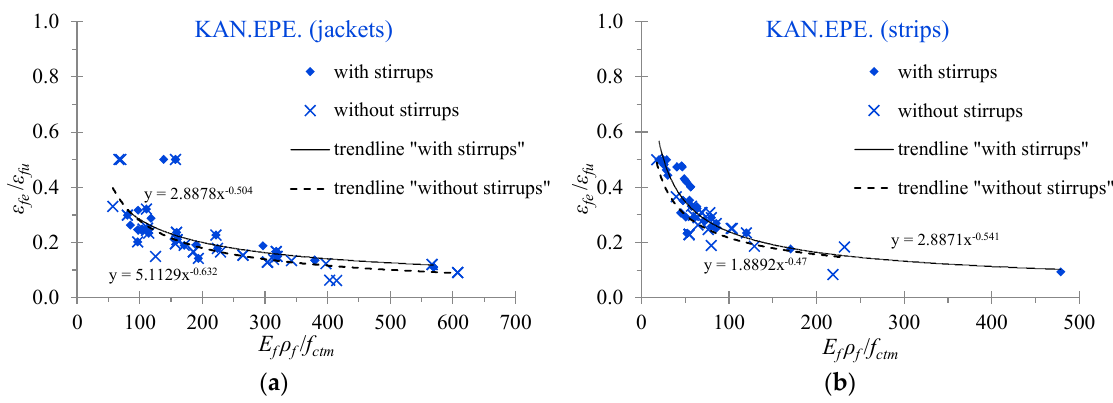
Figure 9. Effectiveness of the EB-FRP U-jacketing based on the provisions of the Greek Code of Interventions (KAN.EPE.): ( a ) U-shaped retrofitted T-beams with EB-FRP jackets; ( b ) U-shaped retrofitted T-beams with EB-FRP strips.